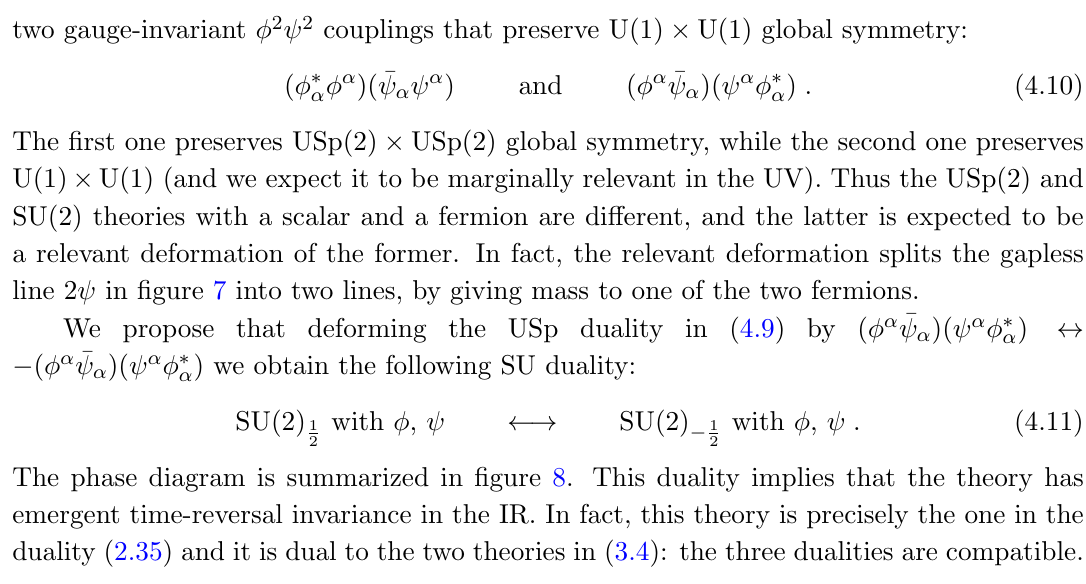
Figure 8 . SU(2) 1 with φ , ψ SU(2) − 1 with φ , ψ . Phase diagram. We have not indicated / 2 / 2 ←→ the gravitational couplings along gapless lines, for simplicity. The duality predicts emergent time- reversal invariance around the origin, along the dashed